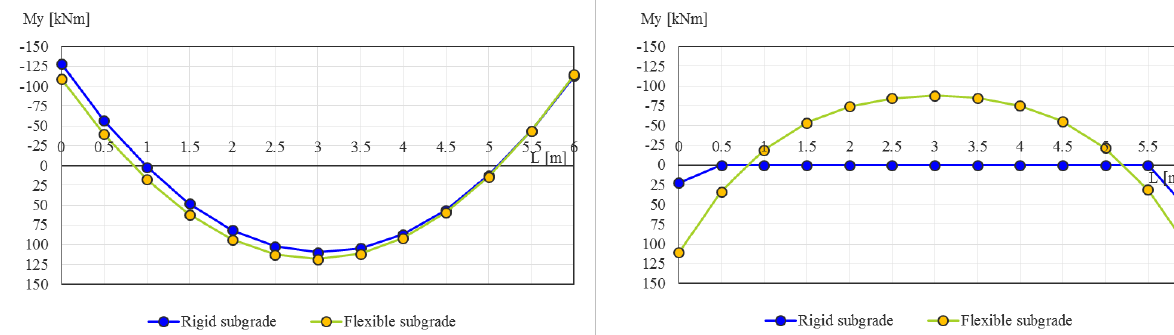
Figure 8: Distribution of bending moments in bridge’s upper floor slab model on a rigid subgrade. Whereas in the zone at the side walls the reverse is the case. If subgrade flexibility is not taken into account in the model, this can lead to excessive deflections and cracking of the floor slab at its midspan and to the over-reinforcement of the slab parts close to the side walls.